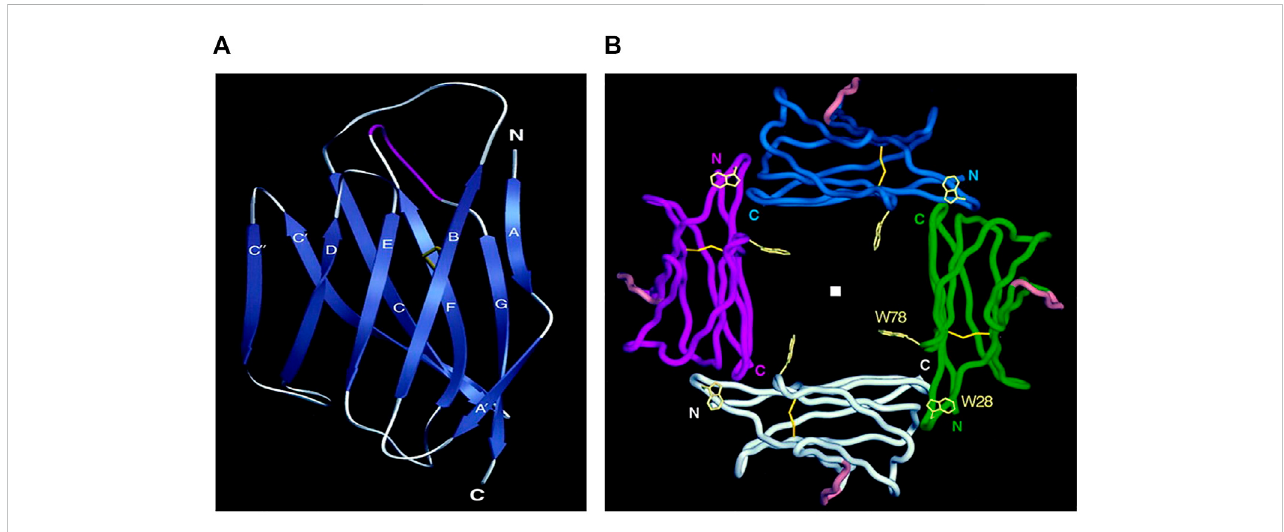
FIGURE 2 Structure of myelin protein zero. (A) : Extracellular domain with labeled 10 beta strands in the standard immunoglobulin designation. Strands A (2-4), B (17-24),D(70-73)andE(82-85)makeuponebeta-sheet,andstrandsA ’ (8-11),C(33-40),C ’ (47-54),C"(57-60), F(93-101)andG(109-118)makeuptheother beta-sheet. Five residues make major contributions to the formation of the dimer: Trp 57, Asp 61 (C — C ’ loop), Lys 84, Gly 85 (loop C ’— C"), and Ser 106 (loop C" — D). (B) :FourextracellularIg-likedomainsformatetramerThepositionofthefourfoldaxisisindicatedbyasquare.N-termini andCtermini pointthe beginning and the end of amino acid chains, respectively. Trp-28 makes van der Waals contacts with main chain atoms of the opposing B – C loop Loop. Adapted from Shapiro L et al., Neuron.